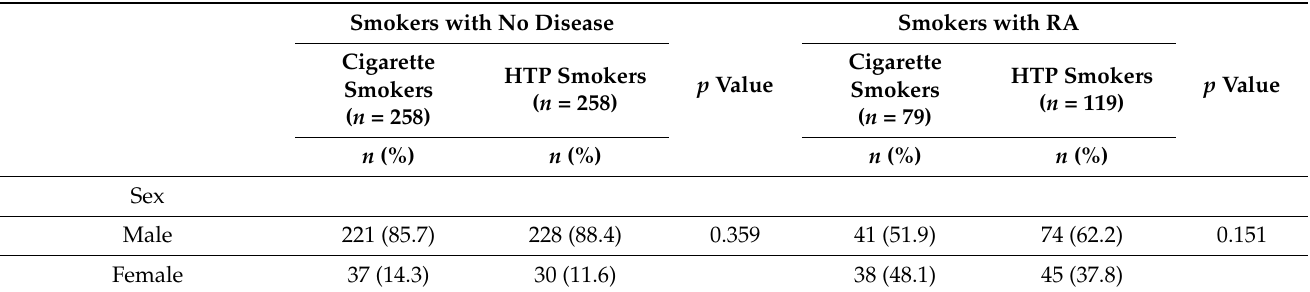
Table 2. Characteristics of participants who completed the secondary